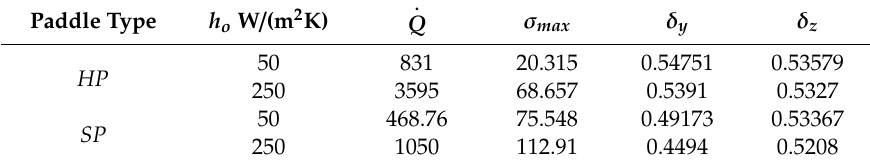
Table 9. Two cases with different h o : Δ T = 100 °C , m = 1 kg/s, H = 62 mm, d = 8 mm, ϕ = 0.53, m = 2.